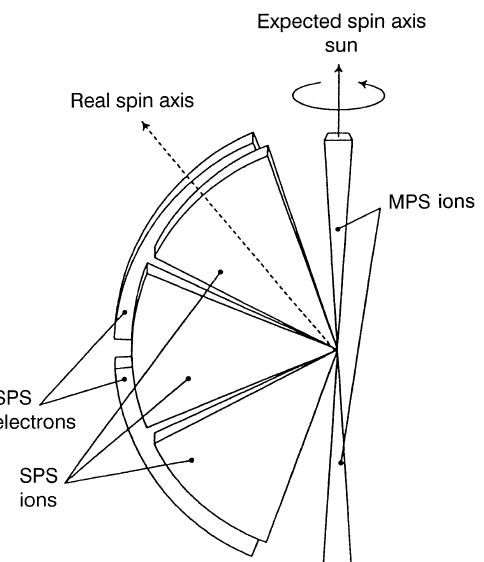
Fig. 3. Schematic plot of the MPS and SPS detectors’ orientation